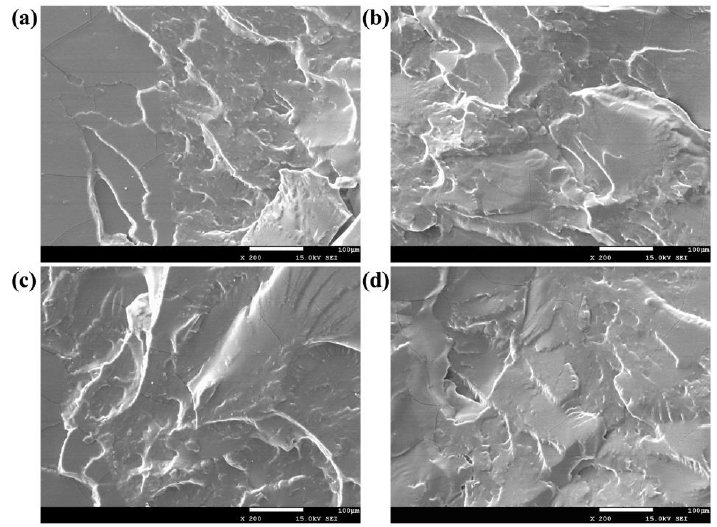
Figure 3. Cross-sectional scanning electron microscopy (SEM) images of PBS-gel and silicone rubber composites. ( a ) 1-MVQ 2 – 40 wt %, ( b ) LPBS-gel/MVQ 3 – 40 wt %, ( c ) PBS-gel/MVQ 4 – 40 wt %, ( d ) HPBS-gel/MVQ.